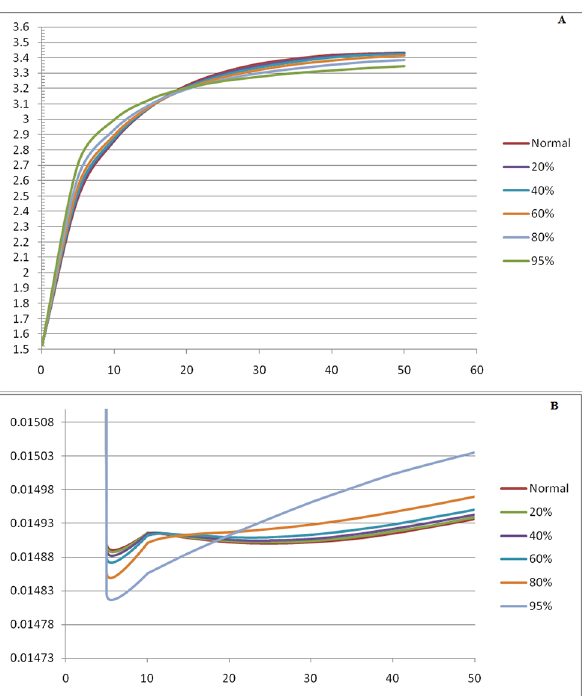
Fig 14. Simulations carried out in COPASI for HEPNet. A. Time course simulation of HEPNet using COPASI showing the variation of concentrations in all the reactions under hypoglycaemic condition. A mol/l vs. time curve has been plot, where we can clearly visualize the behavior of exponential rise in ATP concentration to its maximum in 0.06s whereas that of Glucose is decreasing exponentially with time to 0 in about 0.05s. B. Time course simulation of HEPNet using COPASI showing the variation of concentrations in all the reactions under Hyperglycaemic condition. A mol/(l * s) vs. time curve has been plot, where we can clearly visualize the behavior of exponential rise in Glucose concentration to its maximum in 0.04s whereas that of ATP is decreasing exponentially with time to 0 in about 0.04s. C. Flux generated over time in hypoglycaemic condition of all the reactions in HEPNet using COPASI. The e -x plot of mol/s vs. time(s) showing a exponential decrease is due to the flux generated from reactions RE25, RE27, RE34, RE36, RE79, RE84, RE88. The flux becomes 0 in 0.07s. D . Flux generated over time in Hyperglycaemic condition of all the reactions in HEPNet using COPASI. The e -x plot of mol/s vs. time(s) showing steep exponential decrease in comparison to the hypoglycaemic state which is due to the flux generated from the reactions RE25, RE 28, RE31, RE32, RE56, RE80, RE85, RE87. The flux becomes 0 very quickly in a span of 0.05s which is 0.07s in cance of hypoglycaemic